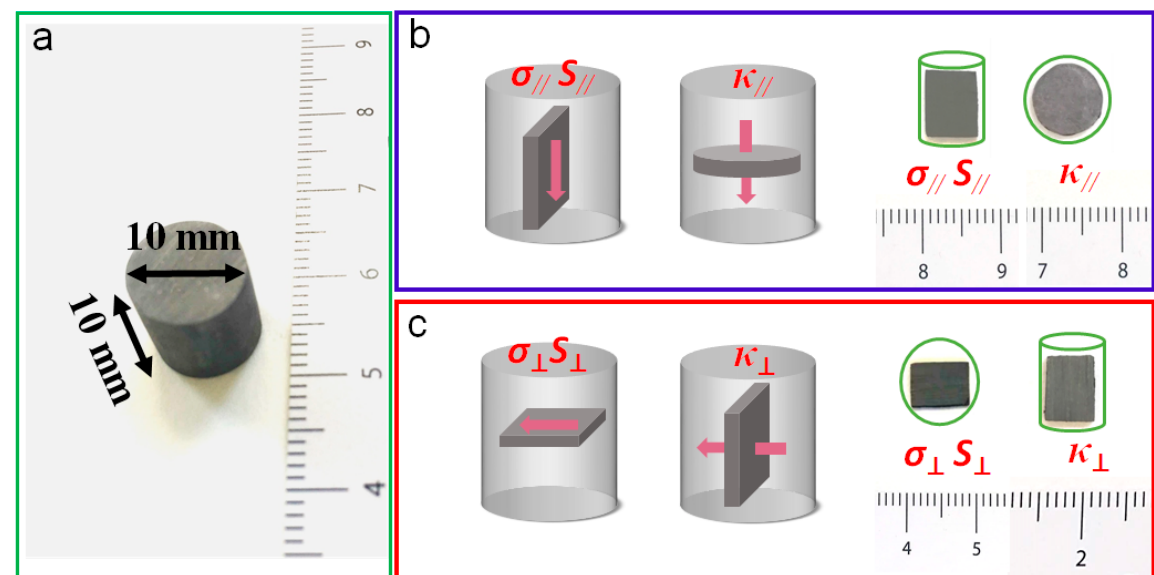
Figure 2. ( a ) Photograph of the consolidated Bi 2 Se 3 cylinder. ( b , c ) Scheme and images of the samples used to measure the material transport properties in the directions parallel ( b ) and vertical ( c ) to the pressure axis.